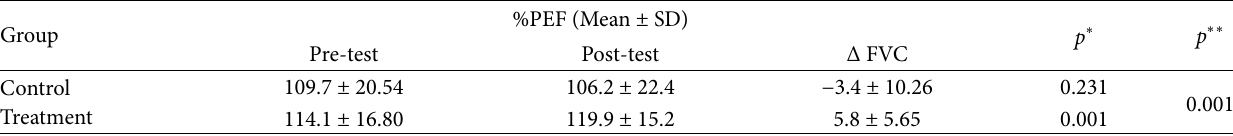
Table 5: Average score of PEF before and after